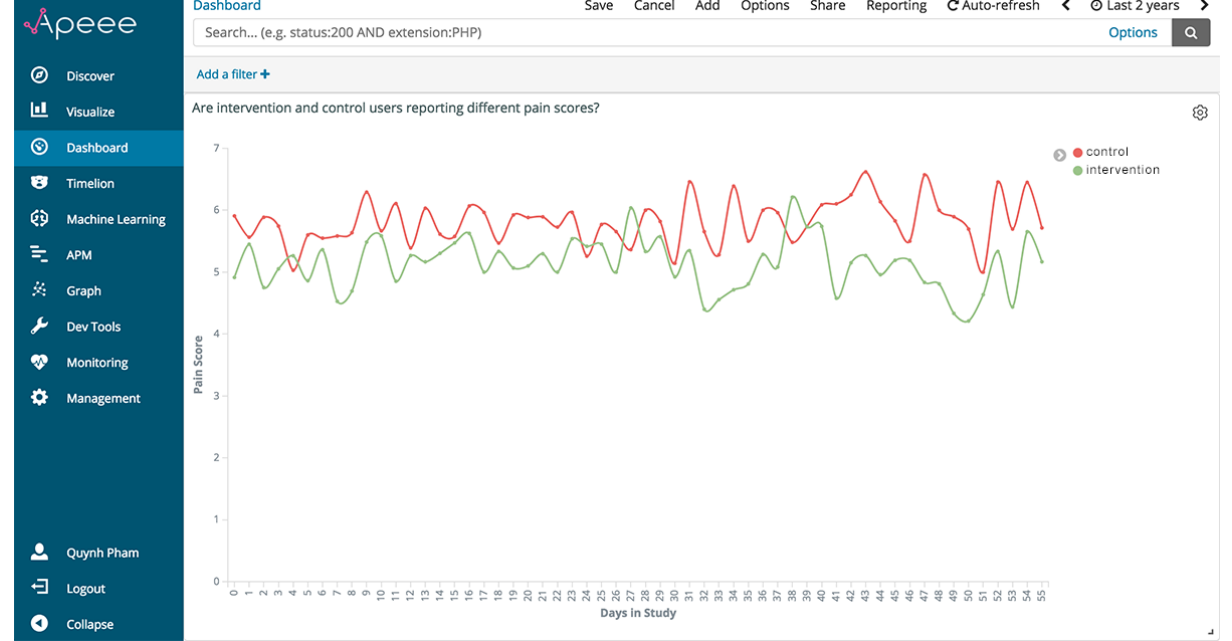
Figure 9. The analytic indicator for “Are intervention and control users reporting different pain scores?,” visualized through APEEE as a line graph. APEEE: Analytics Platform to Evaluate Effective